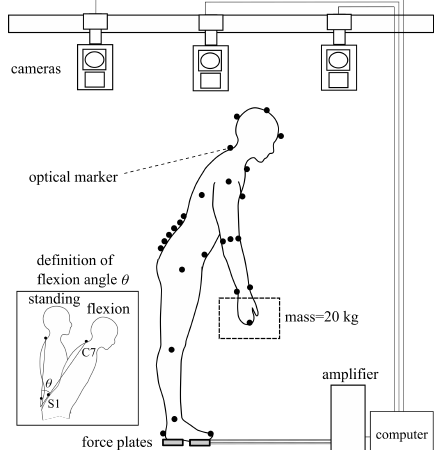
Figure 1. Schematic of experimental setup for obtaining the ground reaction force and motions. Four force plates were used to measure the ground reaction force on both feet, and optical markers were placed all over the body and monitored by the motion-capture system. The external box with a mass of 20 kg was simulated in the compressive force (CF) simulator. The flexion angle θ was considered as an indicator of the flexion